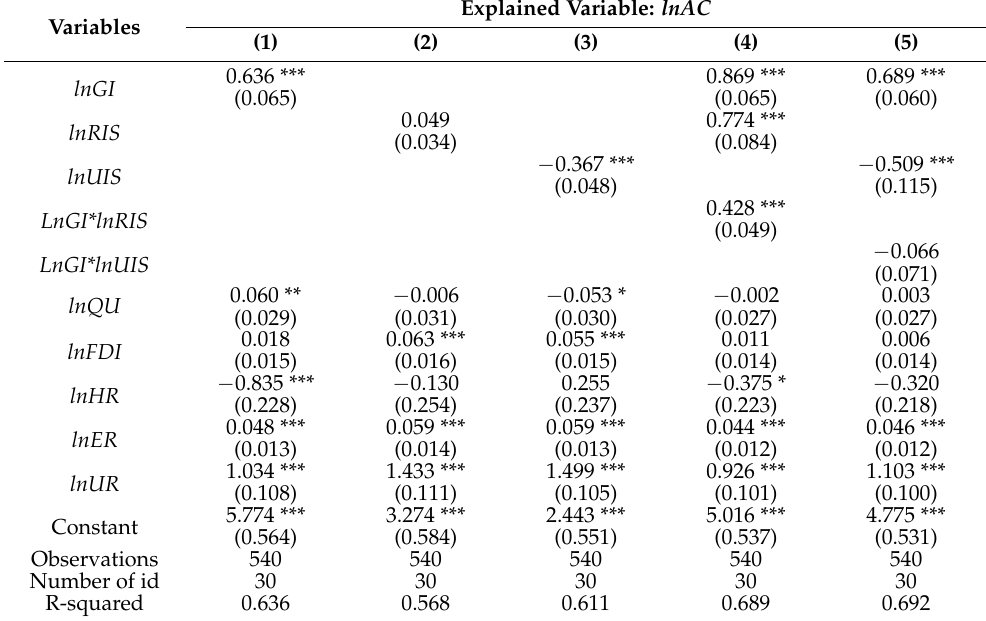
Table 3. Estimated results on the basis of the basic